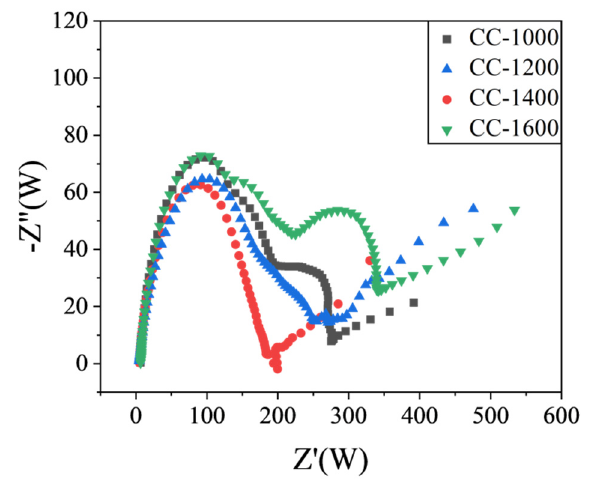
Figure 6. Electrochemical impedance spectra (EIS) of CCs.